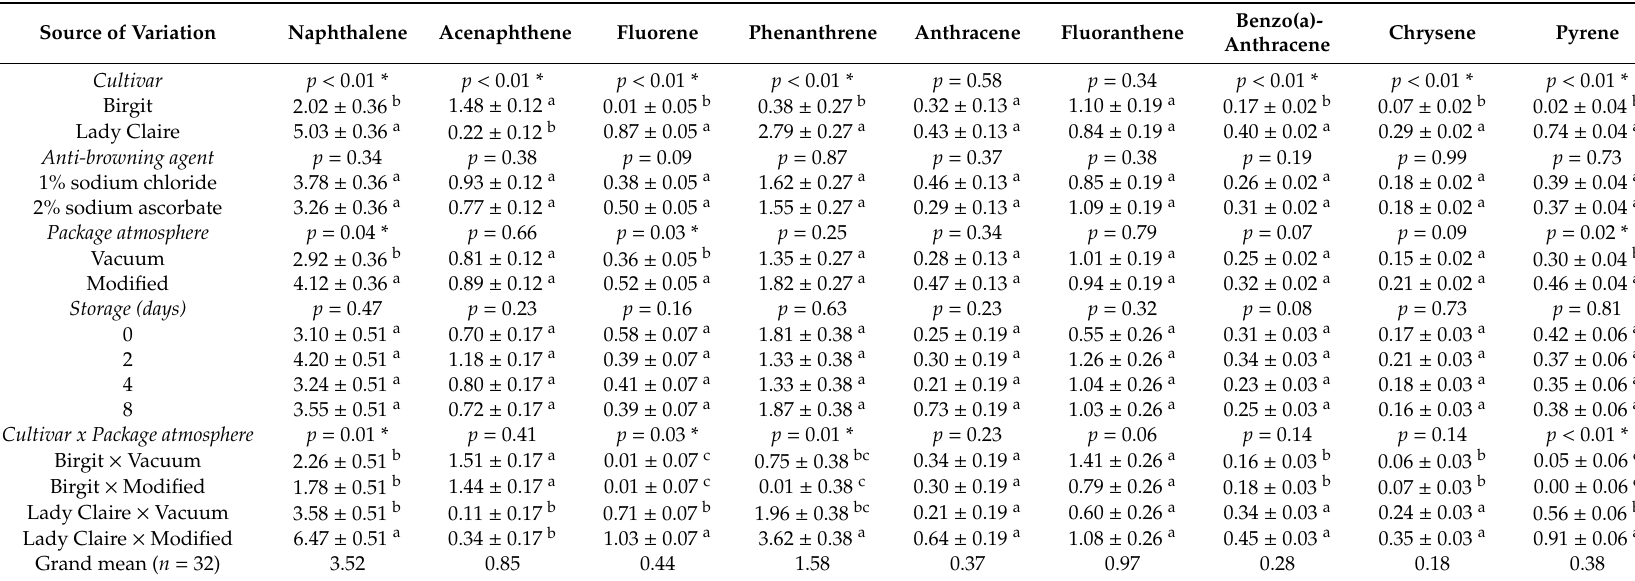
Table 3. Light (2–4 rings) PAH fraction ( µ g kg − 1 ) in fried fresh-cut potato as a ff ected by cultivar, anti-browning agent, packaging and storage